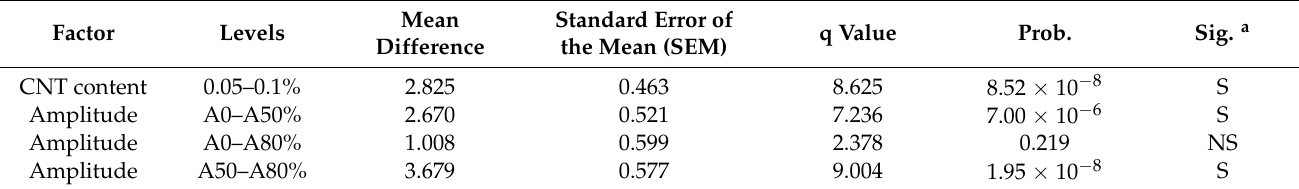
Table 7. Tukey’s multiple comparison test of compressive strength